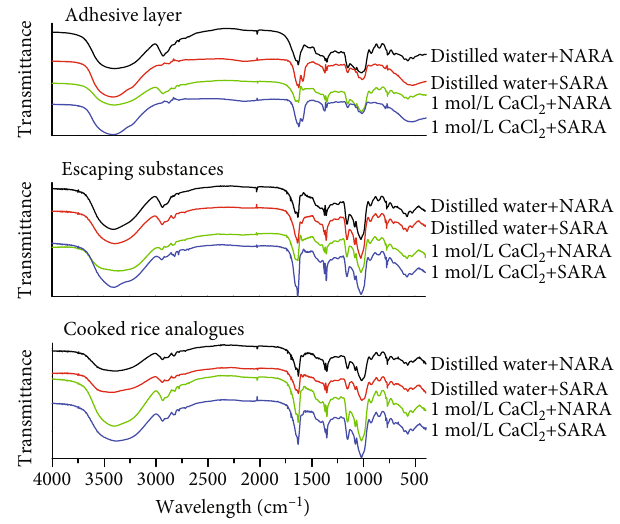
Figure 4: Fourier transform infrared spectroscopy of rice analogues. NARA: rice analogues with nonadditive; SARA: rice analogues containing sodium